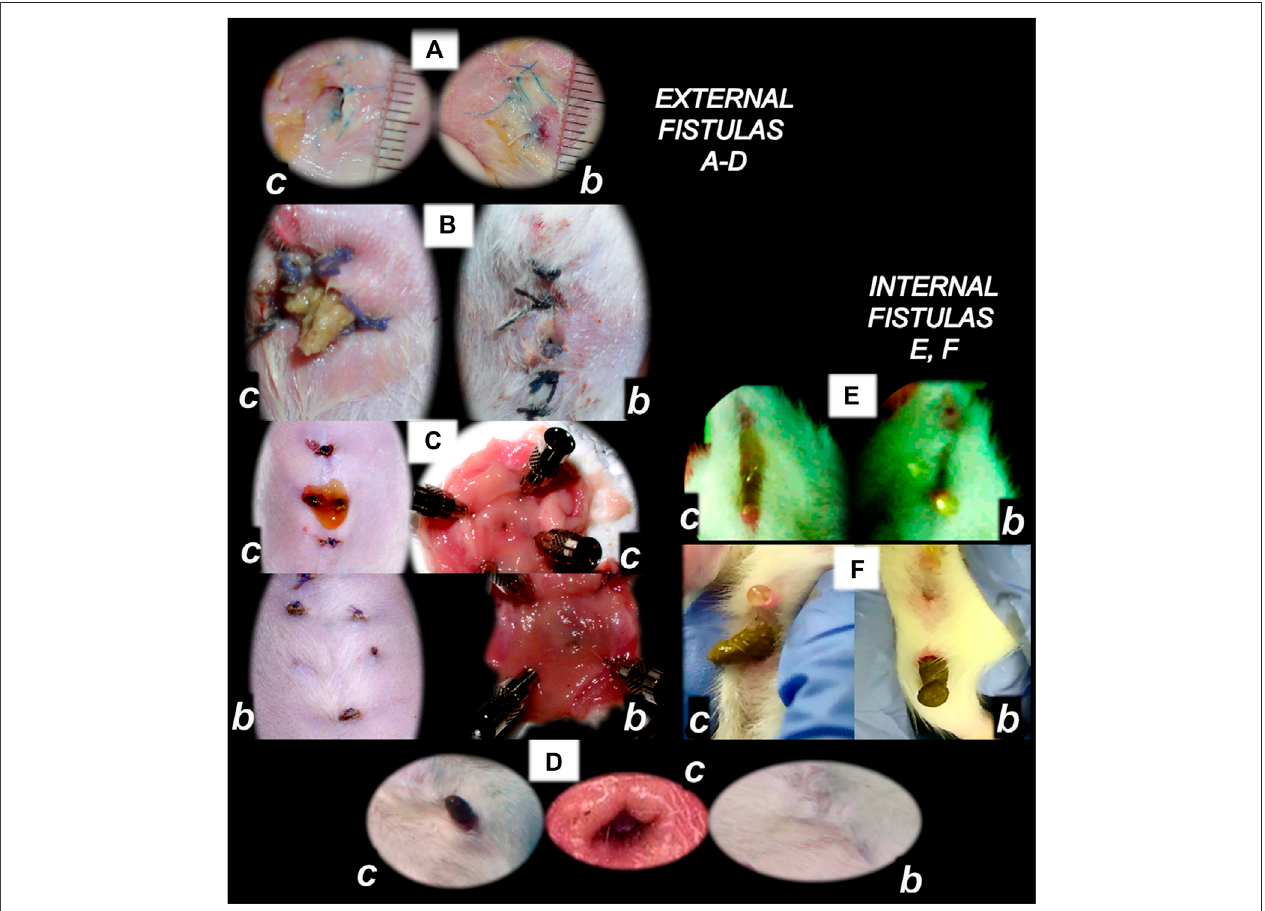
FIGURE 4 | BPC 157 and fi stulas closing. External (A – D) and internal (E, F) fi stulas. External fi stulas. (A) Persistent esophagocutaneous fi stula and BPC 157 therapy effect. BPC 157 was given per-orally, in drinking water (10 μ g/kg, 10 ng/kg, i.e., 0.16 μ g/ml, 0.16 ng/ml, 12 ml/rat/day) until sacri fi ce, or intraperitoneally (10 μ g/kg, 10 ng/kg) with fi rst application at 30 min after surgery, last at 24 h before sacri fi ce. To establish NO-system involvement, L -NAME (5 mg/kg i.p.) (worsening) and/or L -arginine (100 mg/kg i.p.) (bene fi cial effect) were given alone or together; fi rst application at 30 min after surgery, last at 24 h before sacri fi ce. BPC 157 (10 μ g/kg, i.p. or p.o.) given with L -NAME (5 mg/kg i.p.) and/or L -arginine (100 mg/kg i.p.) and it maintained its original bene fi cial effect. A closely interrelated process of unhealed skin, esophageal defects, unhealed fi stulas (upregulated eNOS, iNOS, and COX2 mRNA levels), usually lethal, particularly NO-system – related and